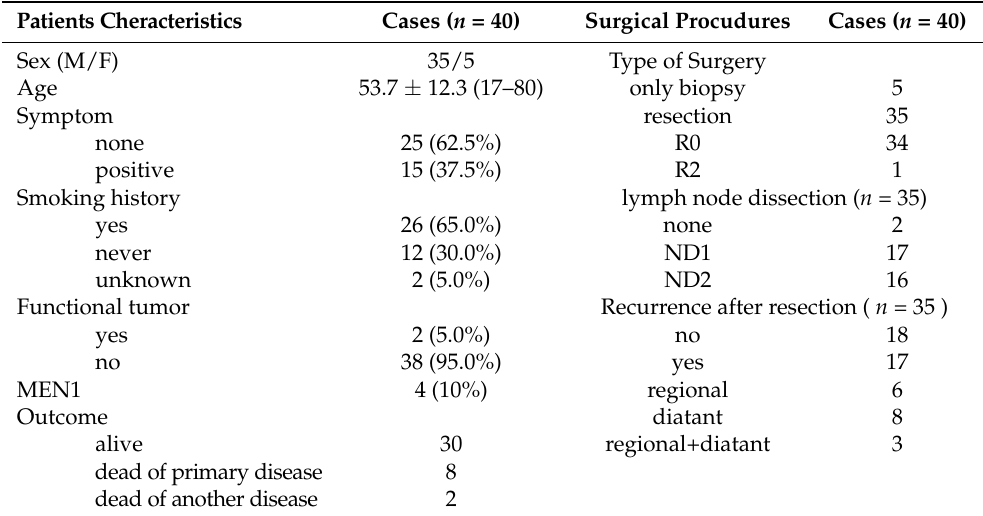
Table 1. Patients’ characteristics, treatment, and outcome. Patients Cheracteristics Cases ( n = 40) Surgical Procudures Cases ( n = 40)